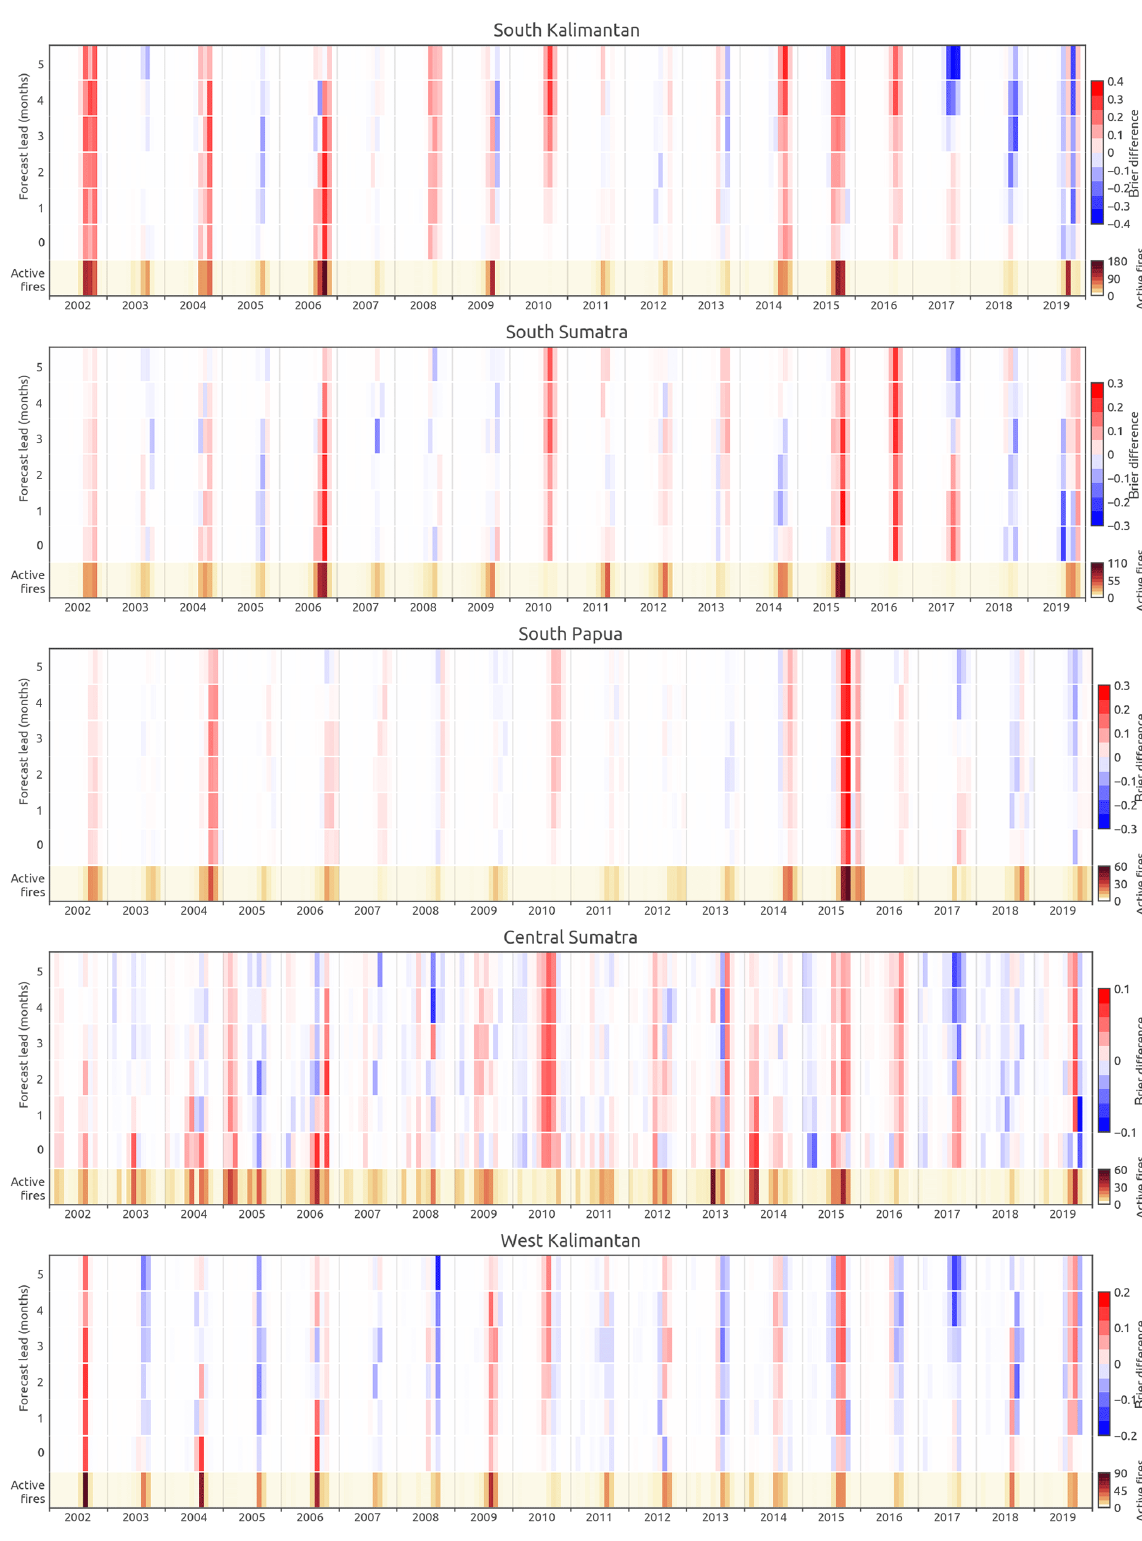
Figure 8. Difference in mean monthly Brier scores between climatology-based and SEAS5-based model predictions of occurrence predic- tions at lead times of 0–5 months of an active-fire count of > 10 cases and a mean monthly active-fire count for the study’s sub-regions. Positive Brier score difference values (red shades) indicate smaller Brier values for SEAS5-based predictions (better), while negative Brier difference values (blue shades) indicate that climatology-based predictions performed better for that month and lead time. Note different colour scales for different